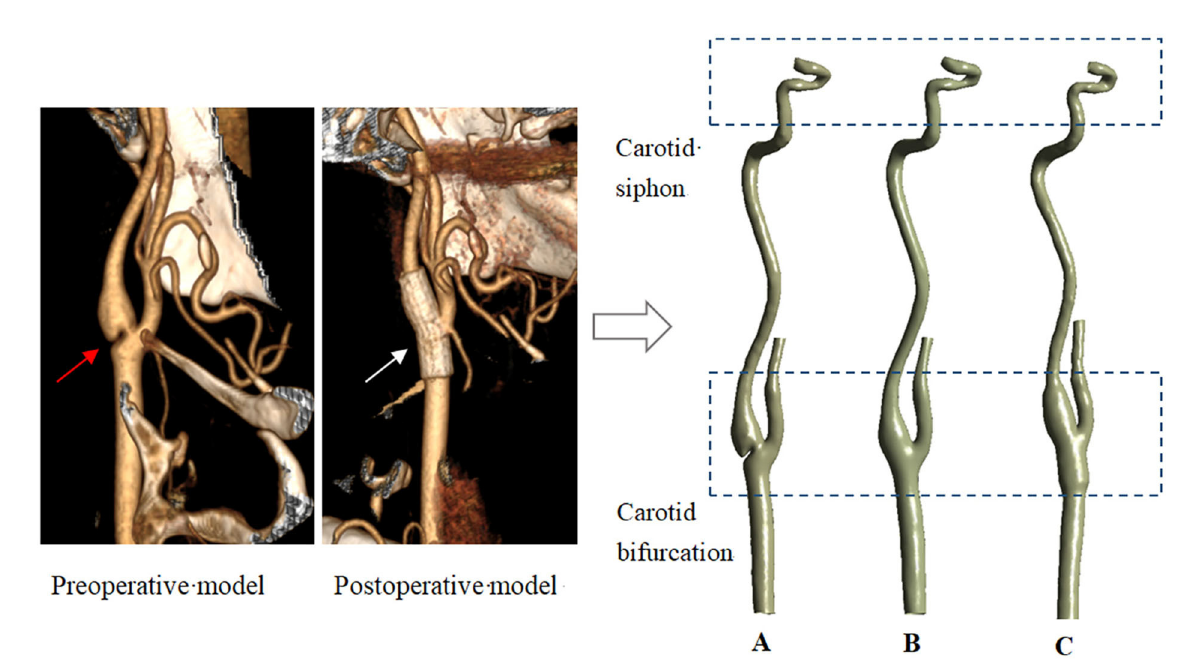
FIGURE1 Three models reconstructed from CT data. ( A –carotid webs model; B –endarterectomy model; C —stenting model. The red and white arrows point to the web and the